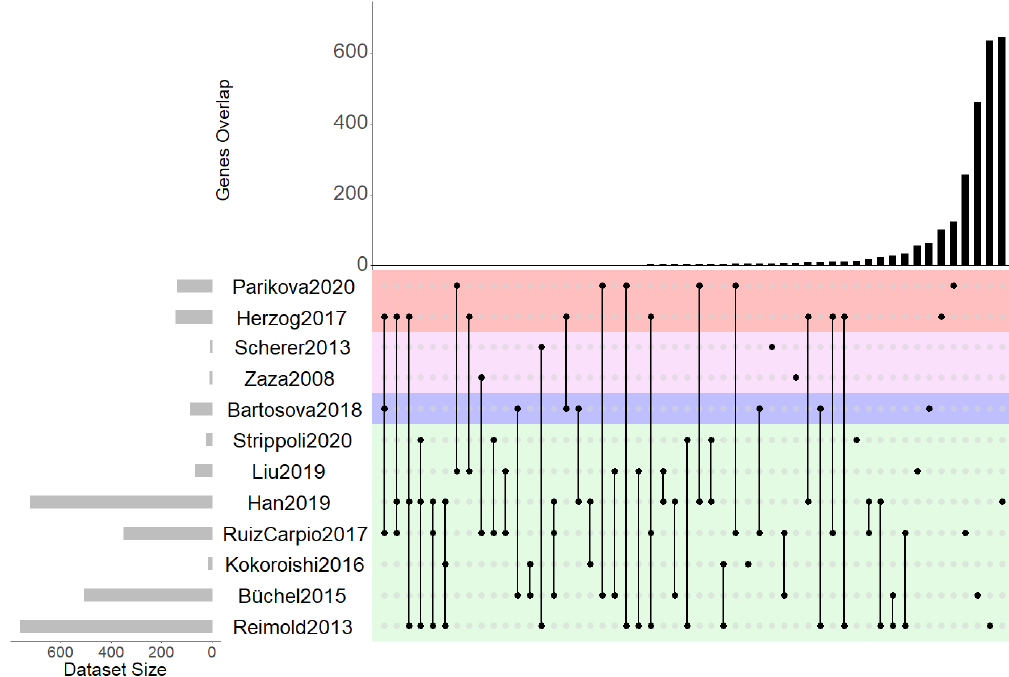
Figure 1. UpsetR plot of differentially expressed genes indicating overlapping genes across the individual studies. Color- coding indicates the four different sample types, namely, mesothelial cells (green), omental arterioles (violet), PBMCs (pink), and peritoneal cells (red).